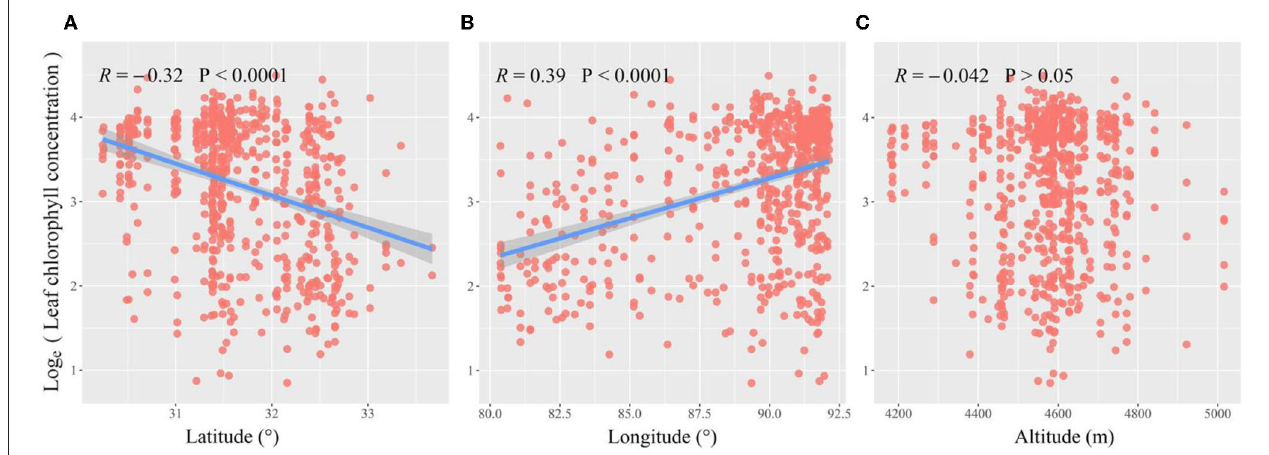
FIGURE 1 | The latitudinal (A) , longitudinal (B) , or elevation (C) patterns of leaf chlorophyll (Chl) across grasslands in the Tibetan Plateau. Red dots represent species-specific observations in each site. The blue lines and shades represent the regression lines with a 95% confidence band.